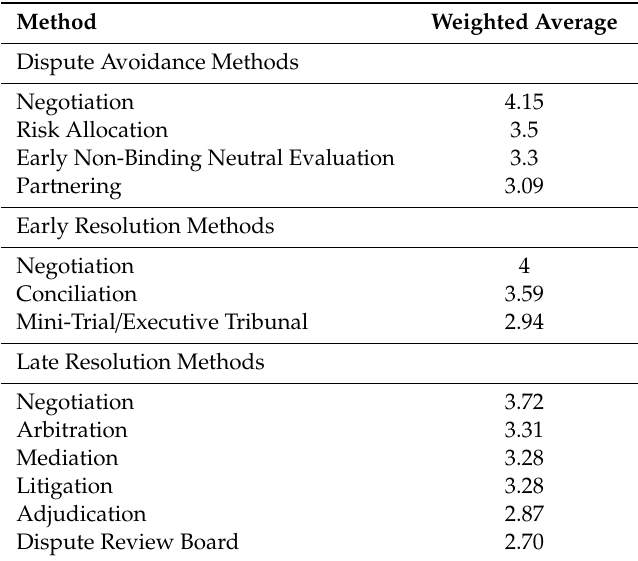
Table 5. Assessment of dispute avoidance and resolution